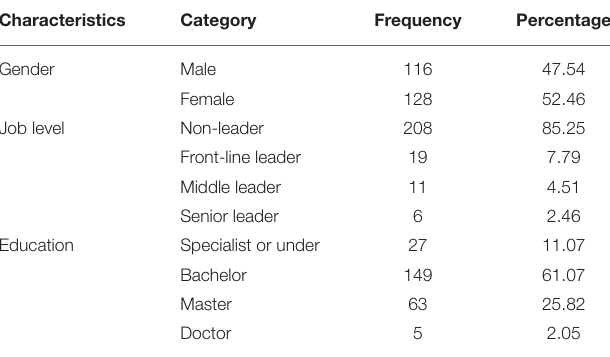
TABLE 1 | Demographic